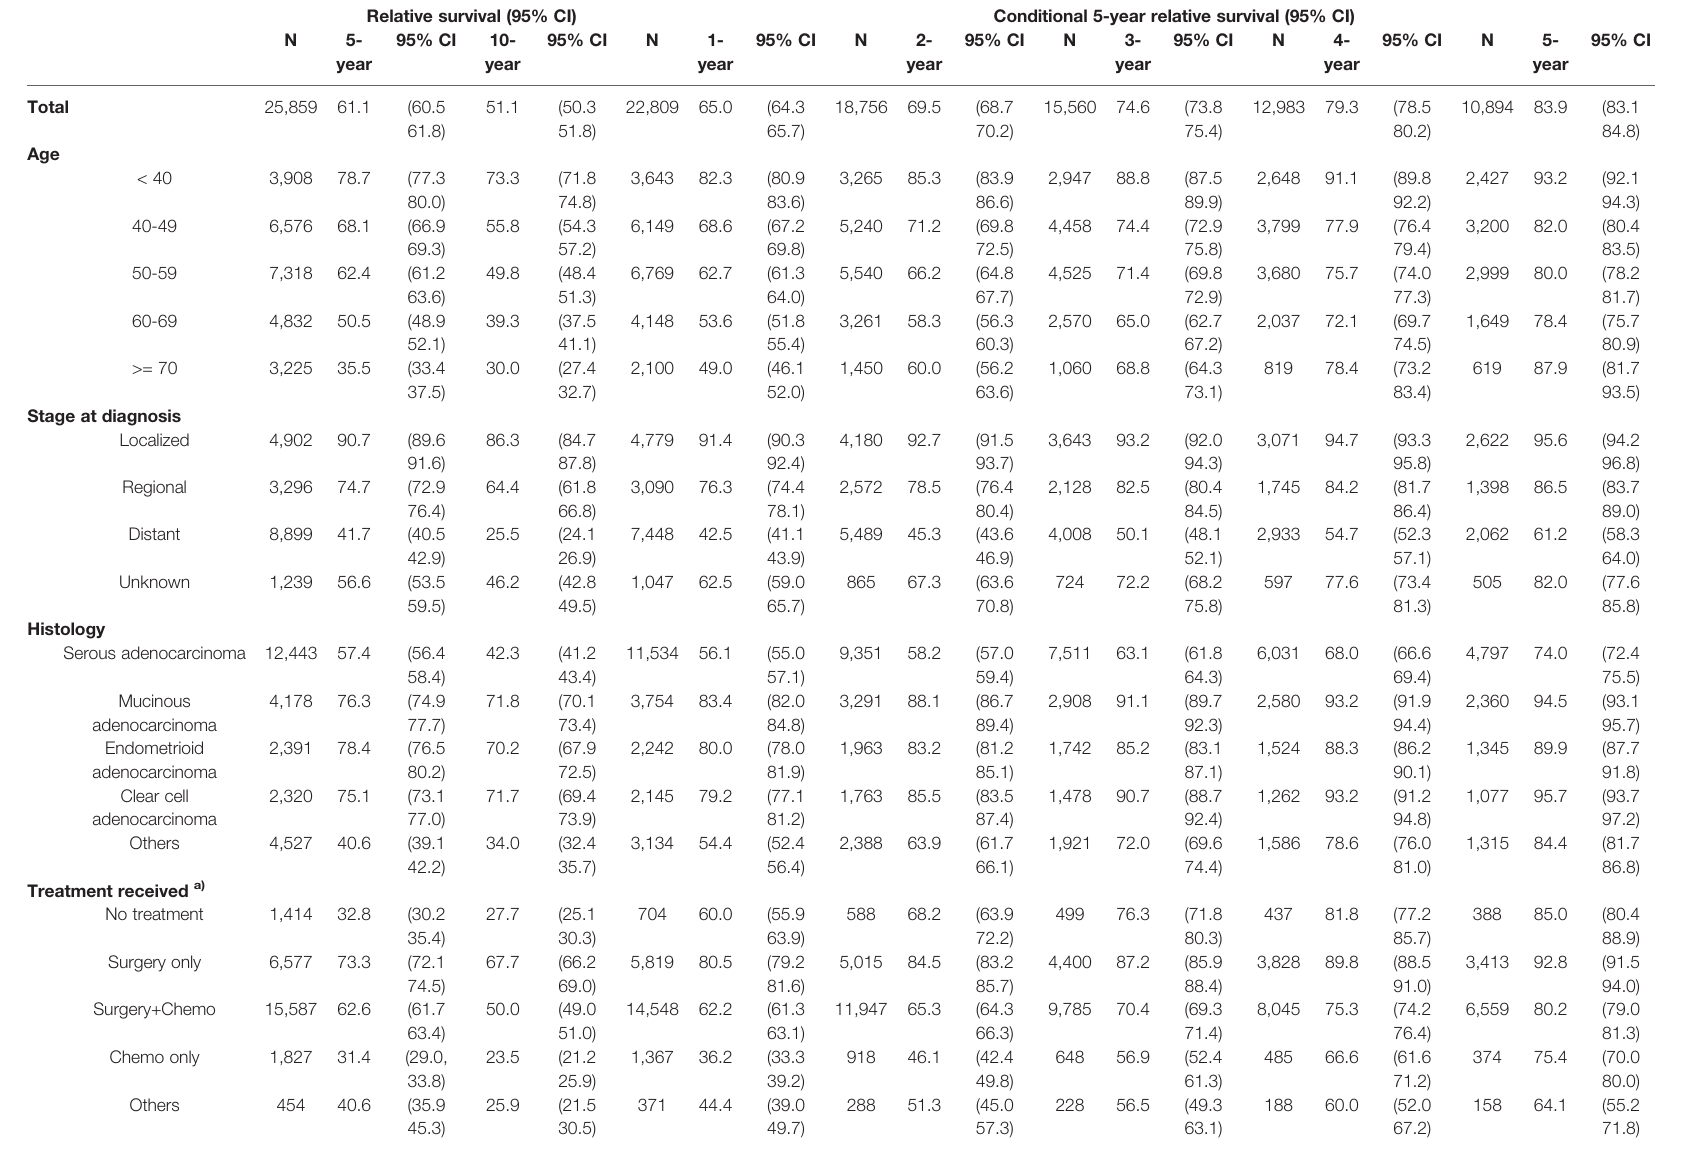
TABLE 2 | Relative and conditional survival (%), 1997 – 2016